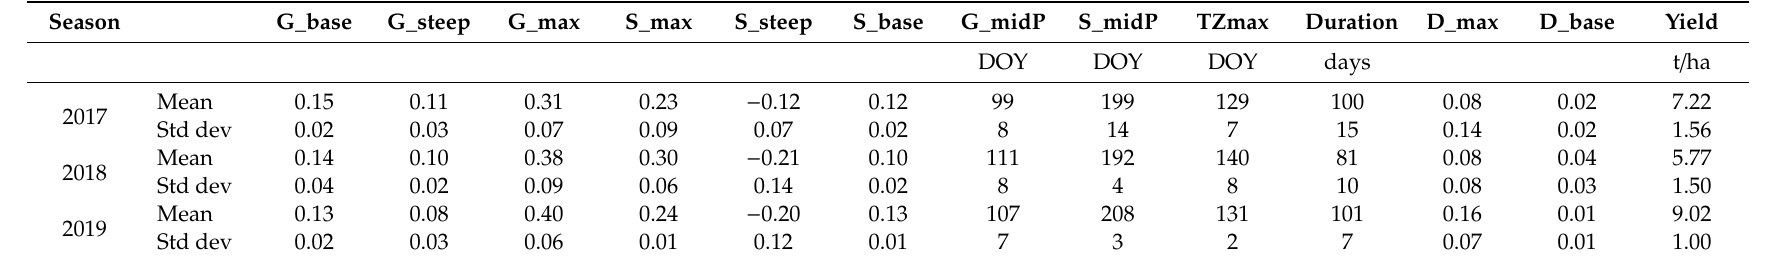
Table 4. Mean and standard deviation values of 12 derived parameters (linear scale) and the wheat yield for each season of the analysis.